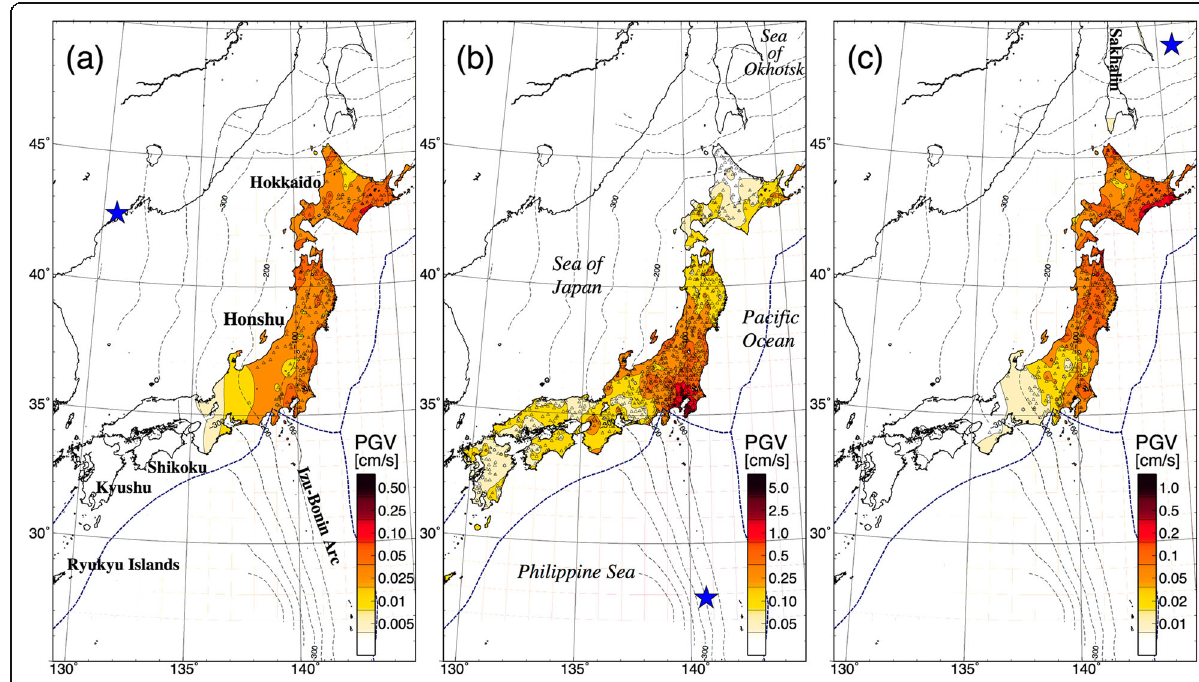
Fig. 1 Peak horizontal ground velocity across the main Japanese islands for a 2010 Mw 6.8 at 578 km depth near the Russia/China border close to Vladivostok, b 2015 Mw 7.9 Ogasawara event at 680 km depth and c 2012 Mw 7.7 event off Sakhalin at 598 km depth. The location of each event is indicated with a blue star. The K-NET and KiK-net strong motion stations that recorded ground motions are marked by triangles. Iso- depth contours for the subducting Pacific slab are shown by broken lines, and plate boundaries are marked by blue